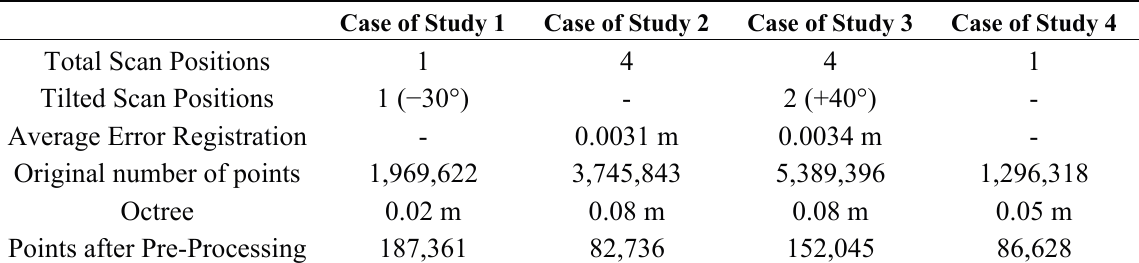
Table 3. Acquisition and pre-processing results.